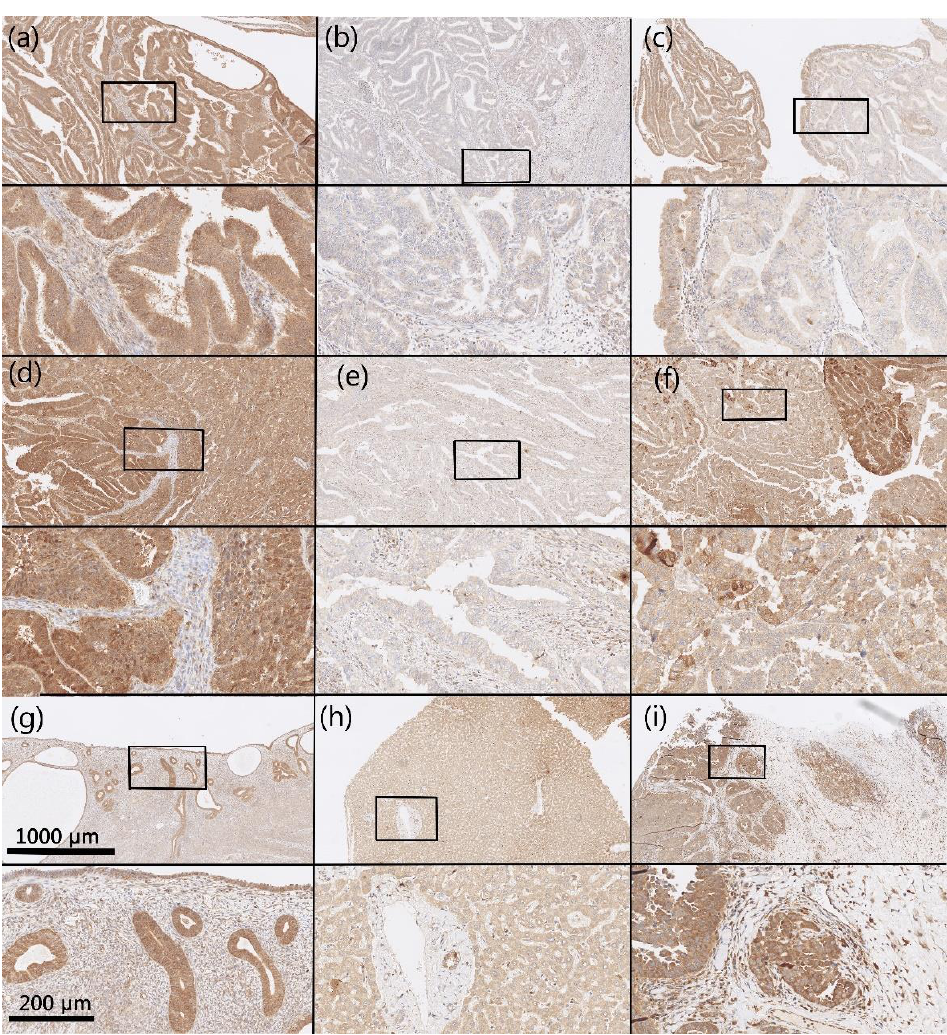
Figure 3. Representative immunohistochemical staining for AKR1B10. Samples of endometrioid EC ( a – c ), serous EC ( d – f ), non-neoplastic endometrial tissue ( g ), control liver tissue ( h ), and control high-grade serous ovarian cancer ( i ). Upper half of panels: 50× magnification; lower half of panels: the framed area from the upper half of the panel (200× magnification). Hematoxylin and eosin (HE) stained sections (Figure S2).